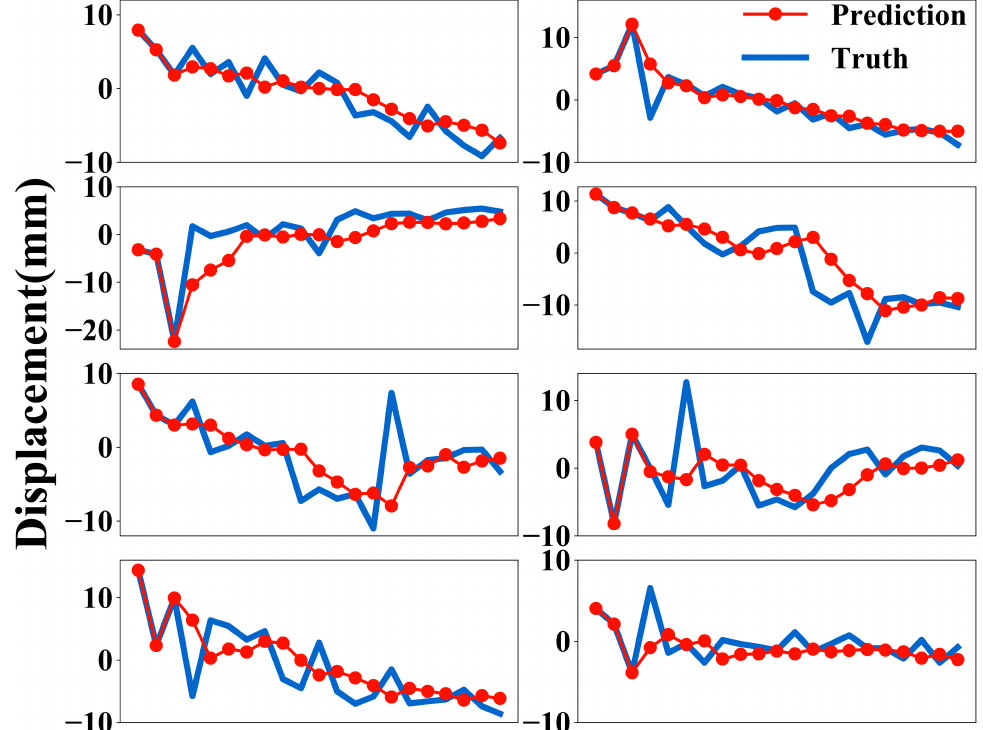
Figure 7. Prediction vs. the